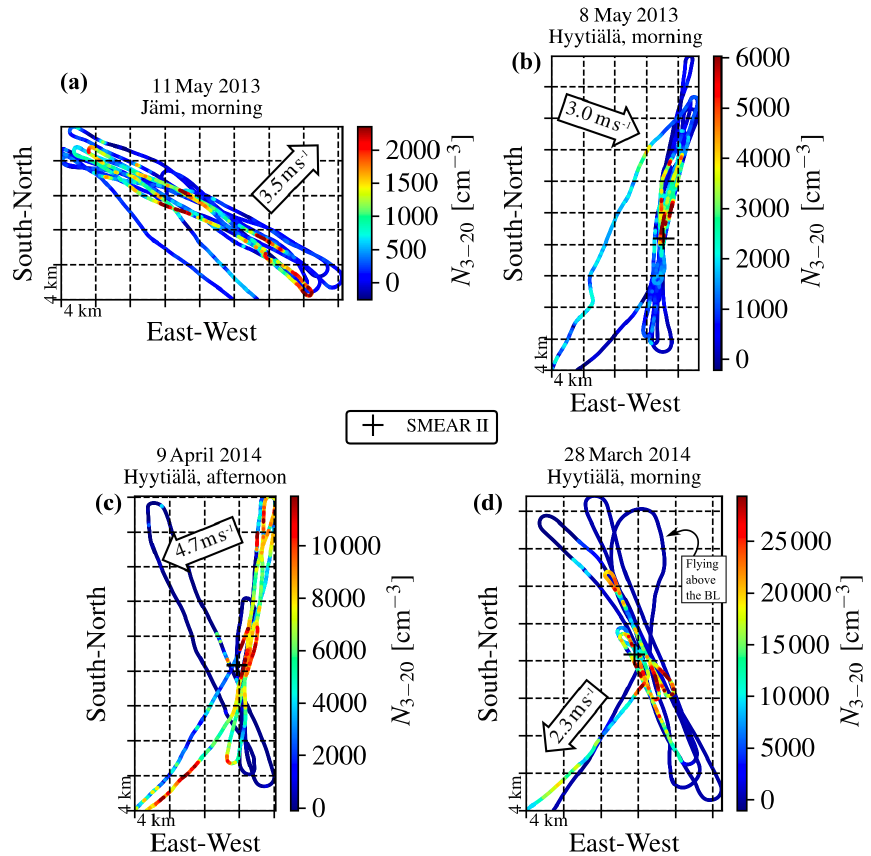
Figure 8. Panels (a–d) show the research airplane’s flight tracks colored by particle number concentration in the 3–20nm diameter range on four different measurement flights. The higher particle number concentrations are displayed on top in order to make the roll-induced NPF more clearly visible. The arrows show the mean wind direction and speed from the SMEAR II